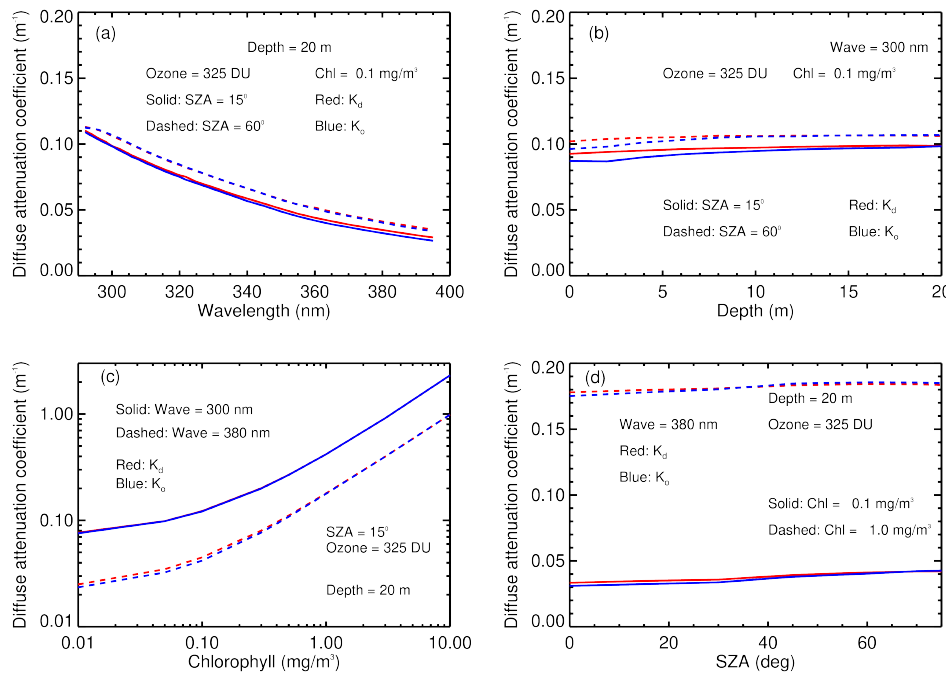
Figure 5. Diffuse attenuation coefficient K d (red lines) and K o (blue lines) as a function of: ( a ) wave- length, ( b ) depth for two SZAs of 15 ◦ (solid lines) and 60 ◦ (dashed lines), ( c ) chlorophyll concentration for two wavelengths 300nm (solid lines) and 380nm (dashed lines) and ( d ) SZA for two values of chlorophyll concentration 0.1mg/m 3 (solid lines) and 1.0mg/m 3 (dashed